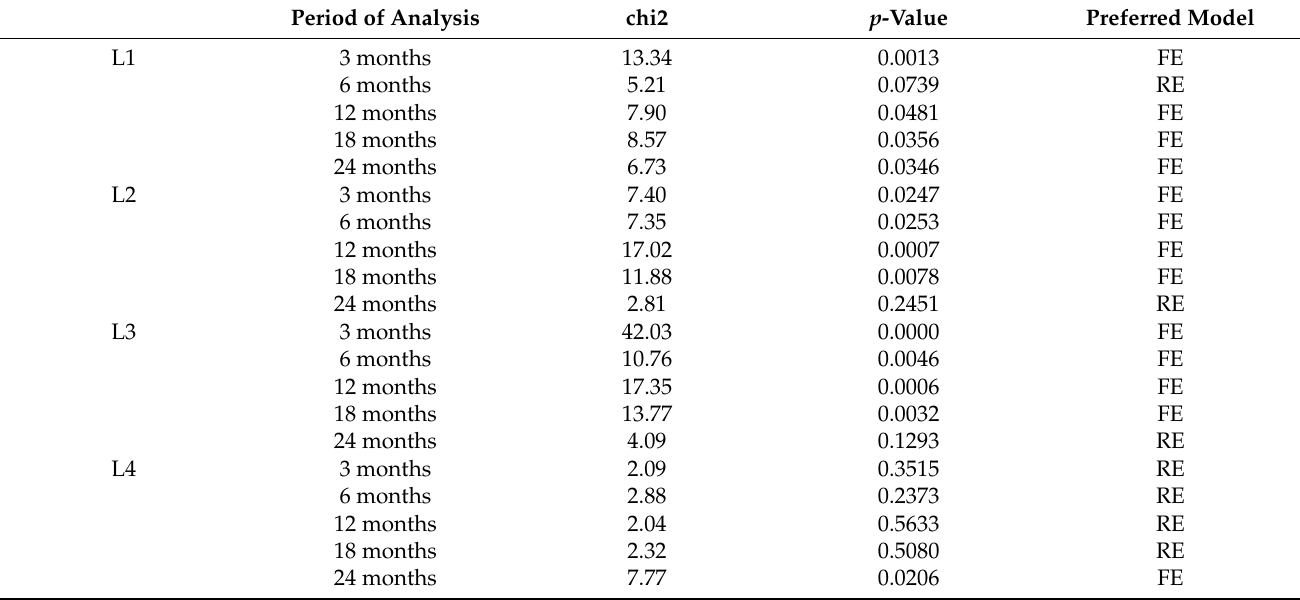
Table 4. Hausman test results for the German